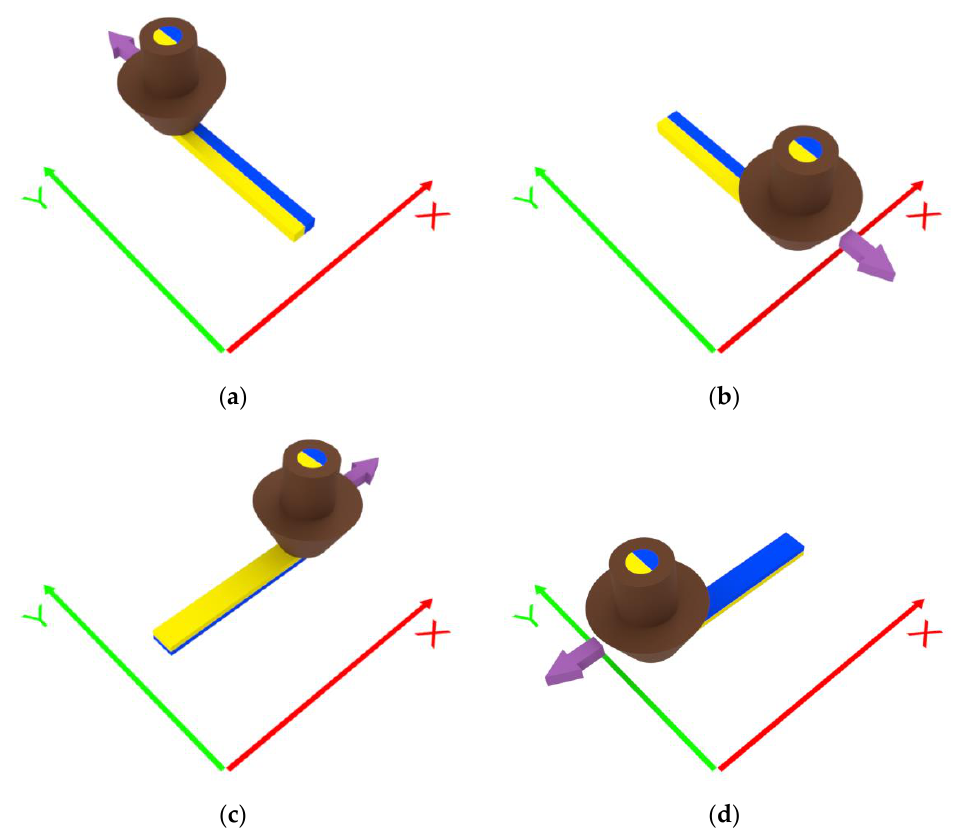
Figure 2. Distribution of the materials deposited depending on the nozzle movement: ( a ) y-positive, ( b ) y-negative, ( c ) x-positive, and ( d ) x-negative directions. In a generic nozzle path, moving from the vertical axis (nozzle axis, z-axis) to the deposition plane (xy-plane), the coextruded materials rotate by 90 ◦ around an axis that is per- pendicular to the deposition direction in the deposition plane ( ⊥ dep. dir. in the xy-plane), as shown in Figure 3a,b. Consequently, for the angle named γ between the x-axis and the deposition direction, the line separating the deposited coextruded materials has the same angle γ .